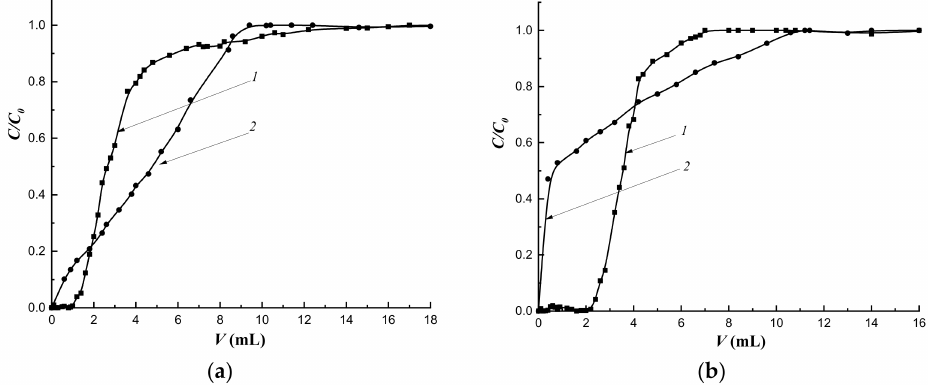
Figure 13. The selectivity of sorption on CP-1 ( a ) and MIP-1-6 ( b ): 1 —cholesterol, 2 —cholic acid. v = 0.25 mL · min − 1 , H = 3.0 cm.